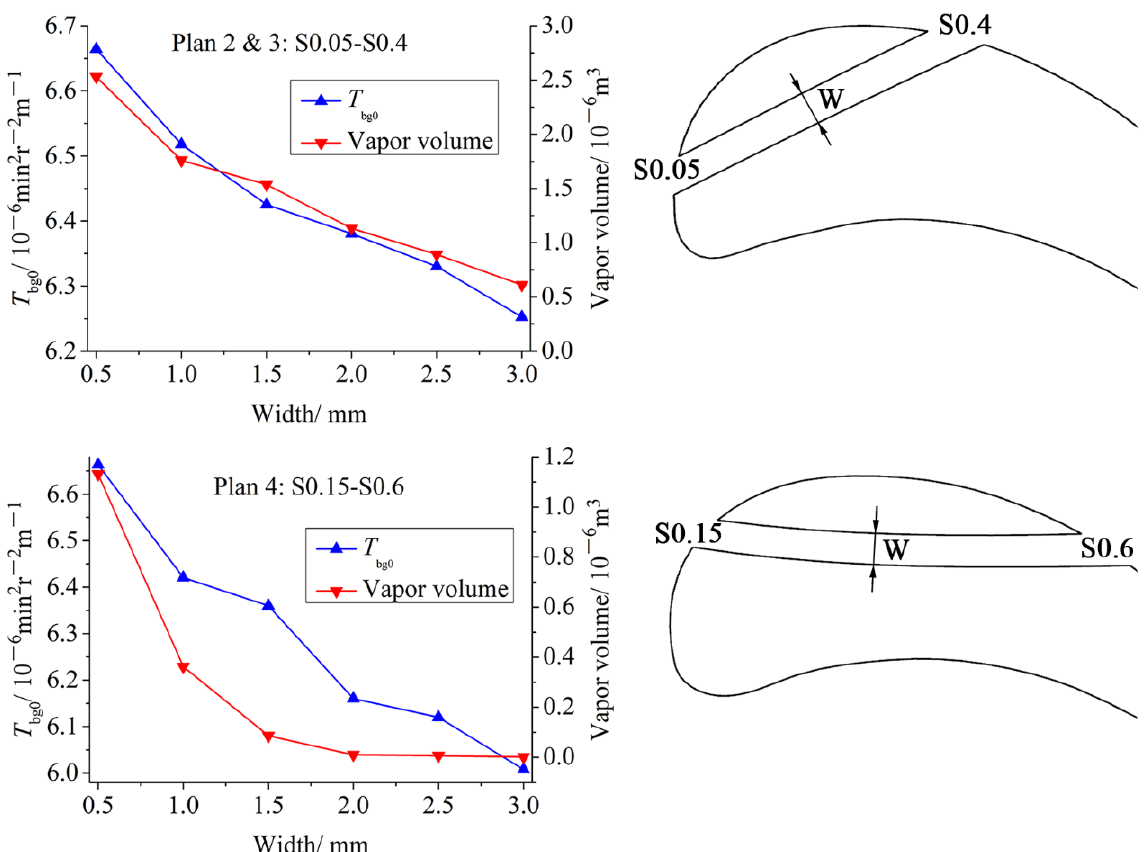
Figure 14. Effect of slot width on T bg0 and stator vapor volume under different slot designs.